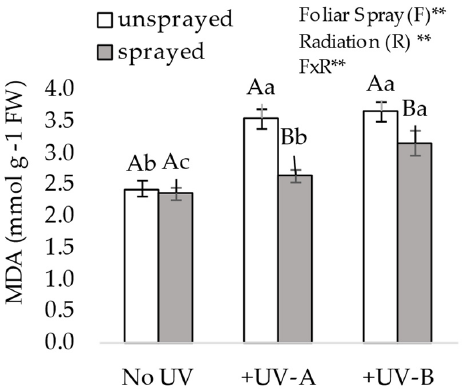
Figure 1. Effect of UVR regimen and/or mitigating treatments on malondialdehyde content. FW (fresh weight). Same uppercase letters within sprayed/unsprayed (intra-treatment) or the same lowercase letters across UVR regimens (inter-treatment) indicate no difference using Tukey’s test ( p < 0.05). ** denote significance among foliar spray and UV radiation, according to the Tukey test (ANOVA).